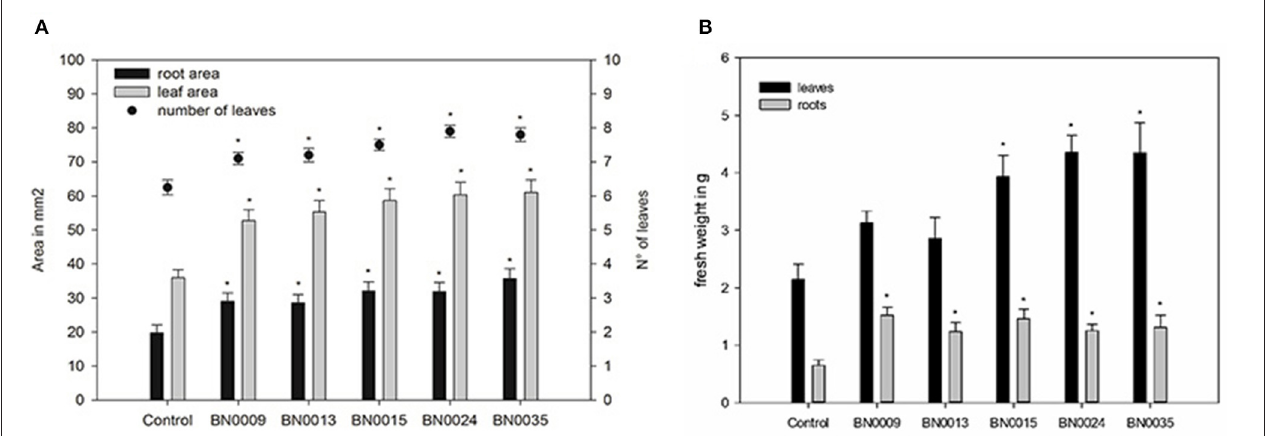
FIGURE 6 | Bacterial effects on the development of lettuce seedlings in pots (vs. control; after 28 days of growth); (A) root and leaf area, number of formed leaves; (B) fresh weight of roots and leaves; asterisks indicate significant difference between respective isolate and control in ANOVA-test.